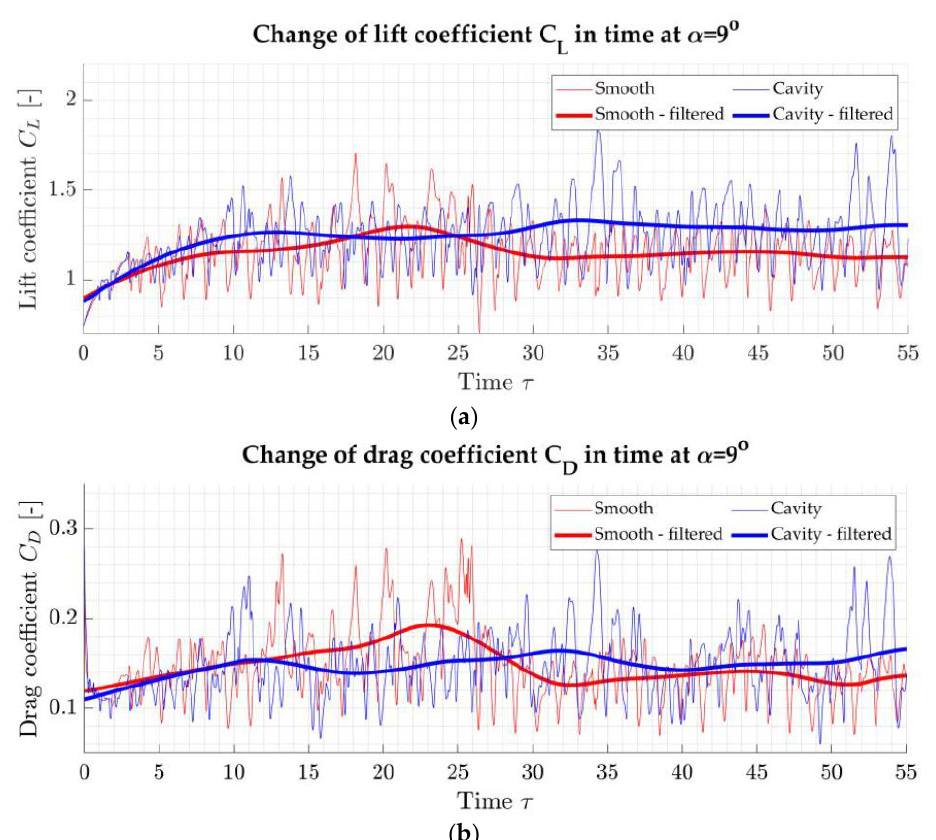
Figure 10. Lift and drag coefficient change in time for Risø airfoil with Cavity A at α = 9 o : ( a ) lift coefficient; ( b ) drag coefficient.